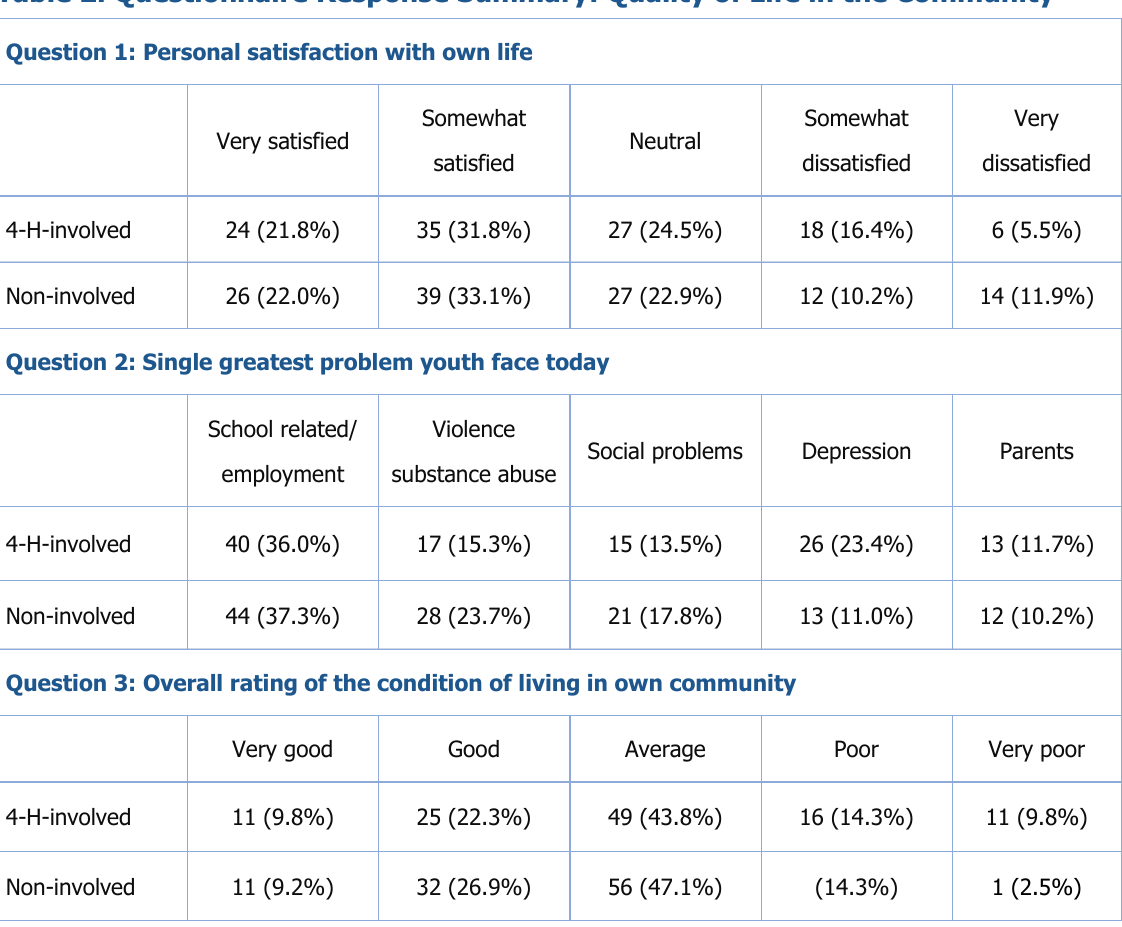
Table 2. Questionnaire Response Summary: Quality of Life in the